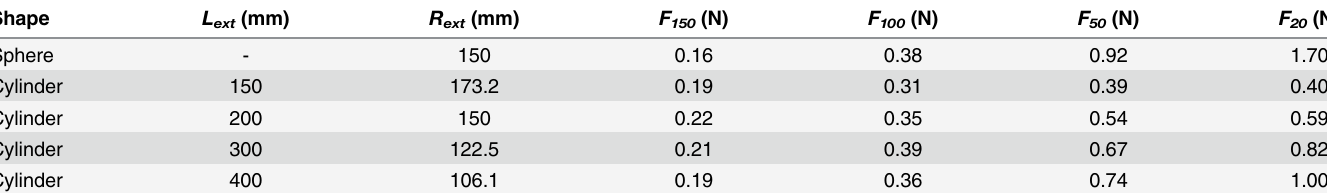
Table 4. Simulation results for different shapes, sizes, and distances of the external